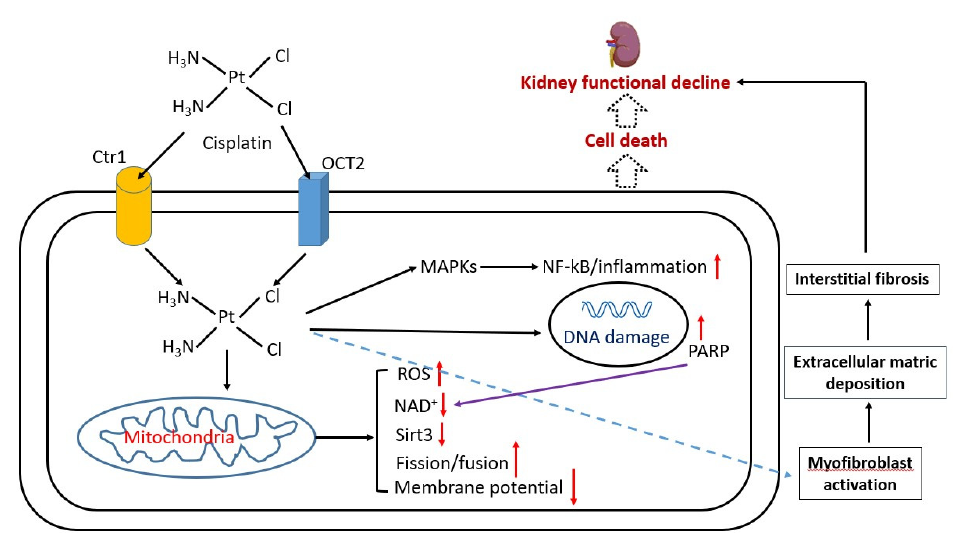
Figure 2. Major pathological mechanisms of cisplatin-induced kidney injury. Cisplatin enters into cell via copper transporter 1 (Ctr1) or organic anion transporter 2 (OCT2) receptors on the cell surface. Once inside the cell, cisplatin can go on to elicit a variety of actions or cellular responses such as nuclear and mitochondrial DNA damage, perturbation of mitochondrial function that can elevate ROS production, and decrease in NAD content and decrease in activity of NAD-dependent enzymes such as sirtuins. DNA damage could activate PARP, which consumes NAD, and in turn could further lower the NAD content, leading to NAD redox imbalance. Cisplatin can also activate inflammation-signaling pathways such as NF-kB activation via MAPKs. These events can result in interstitial fibrosis and eventual kidney failure.